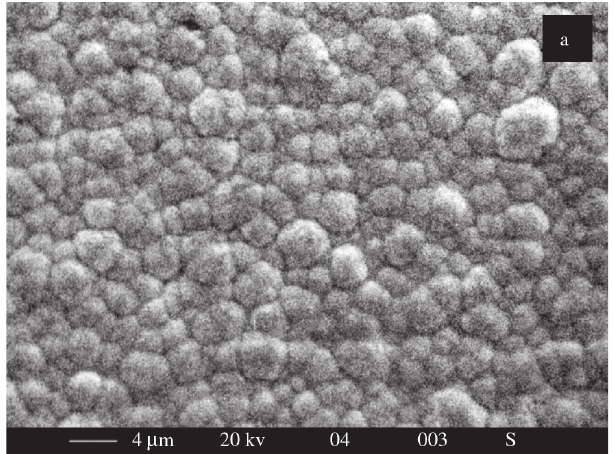
PO 4- more refined microstructure and the absence of pores in the deposits 2 obtained in Bath 2 can be a result of an additional interfacial buffering effect due to the presence of H PO - in the solution 14 2 4